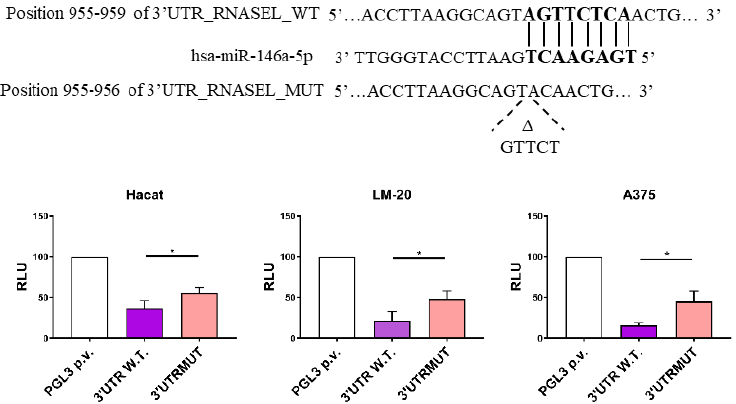
Figure 1. miR-146a-5p (miR-146a) directly regulates firefly luciferase activity through the ribonuclease L (RNASEL) 3′ untranslated regions (3′UTR ). ( Top ) schematic representation of the miR-146a targeting sequence located in the 3′ UTR of the RNASEL gene. ( Bottom ) firefly luciferase assay in HaCaT, LM-20 and A375 cells, respectively. All the results are reported as a mean value ± S.D. Differences in relative expression were analyzed with GraphPad Prism statistical program, using unpaired, two-tailed Student’s t test: * p < 0.05.